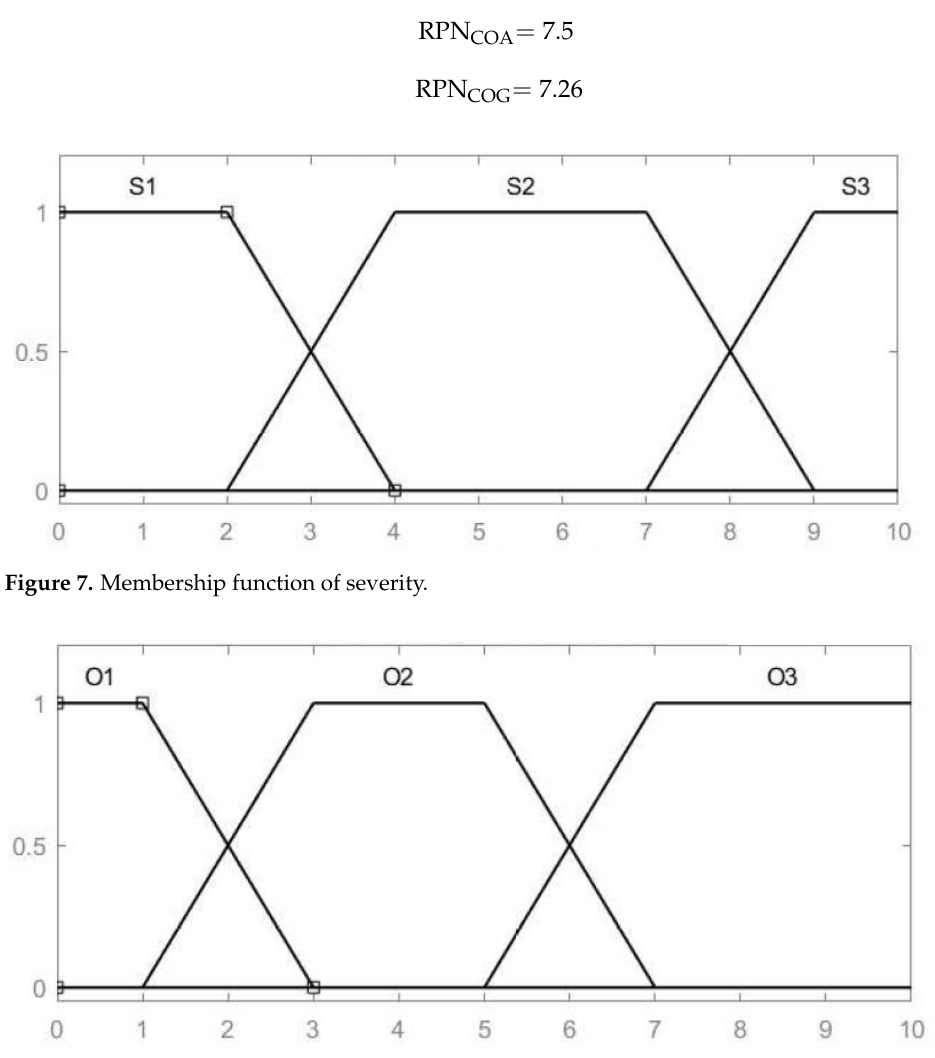
Figure 8. Membership function of occurrence .